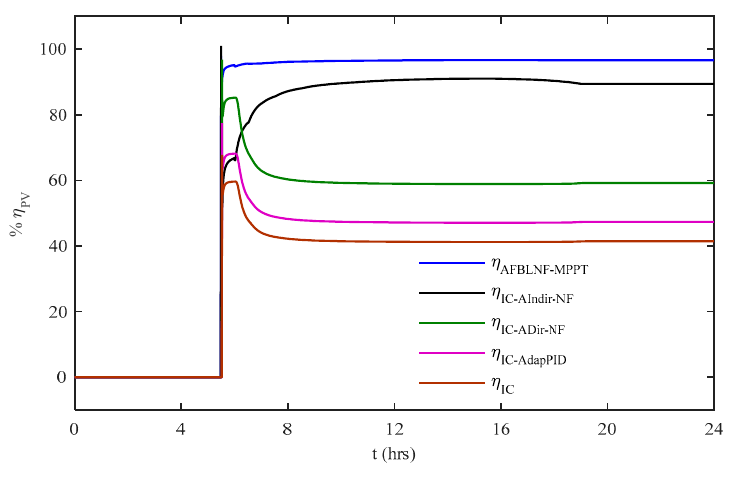
Figure 6. Dynamic efficiency for MPPT of PV subsystem.